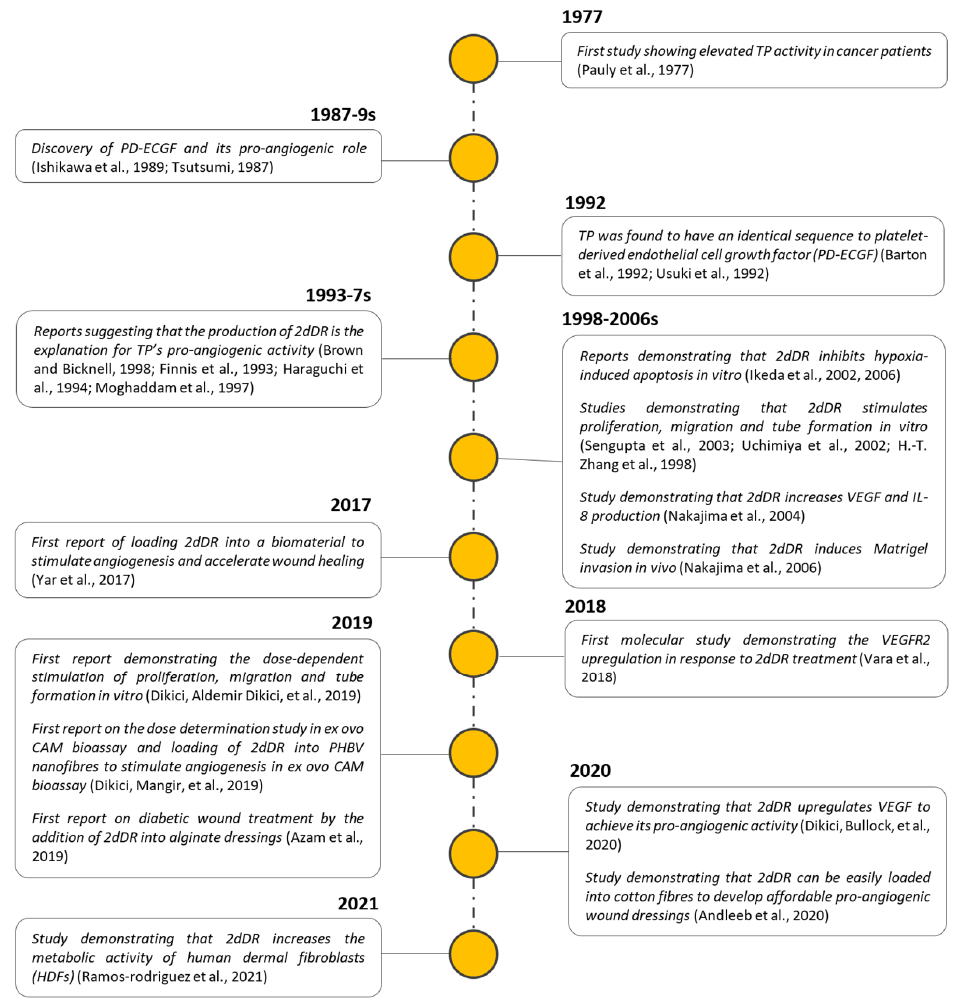
Figure 1. Key milestones of the exploration of 2dDR’s pro-angiogenic activity.